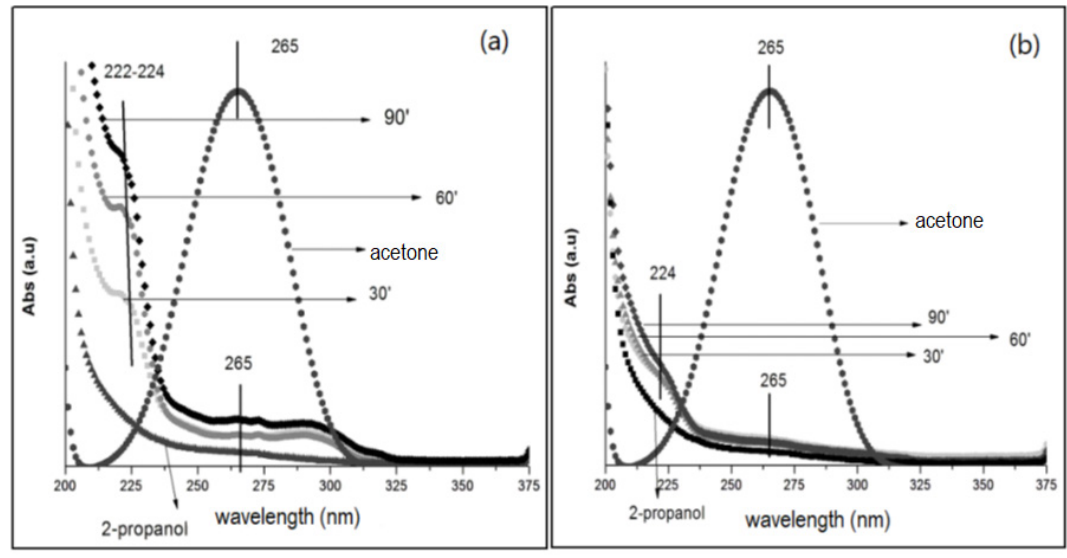
/C as catalyst under 300 nm (a) 2